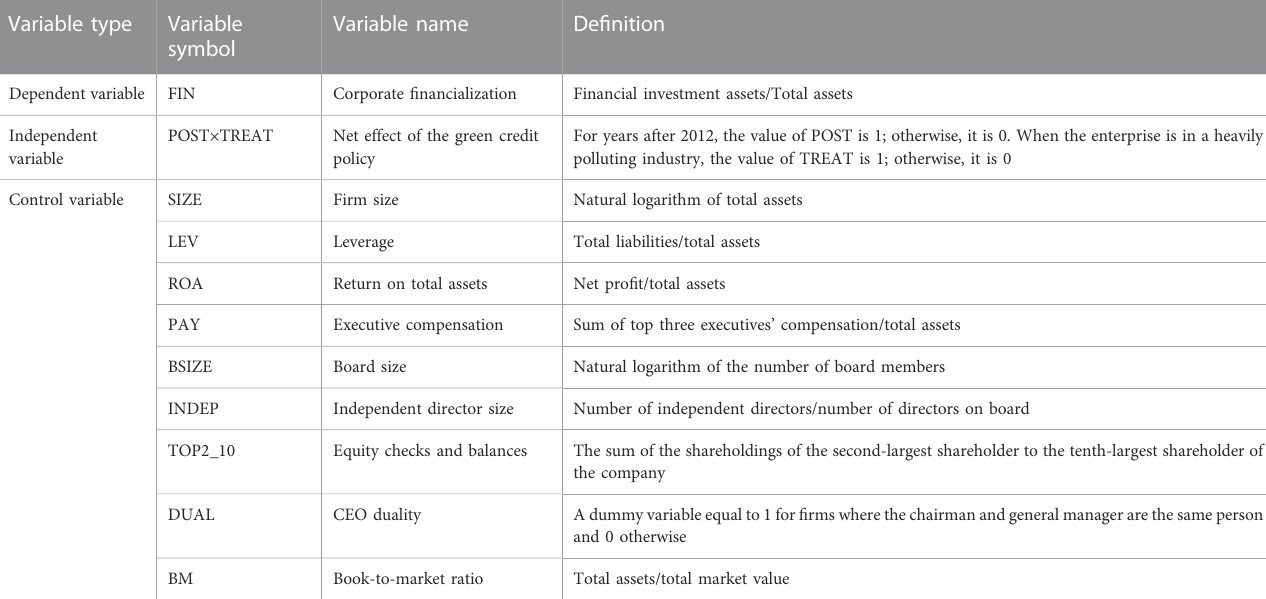
TABLE 1 De fi nition of variables. Variable